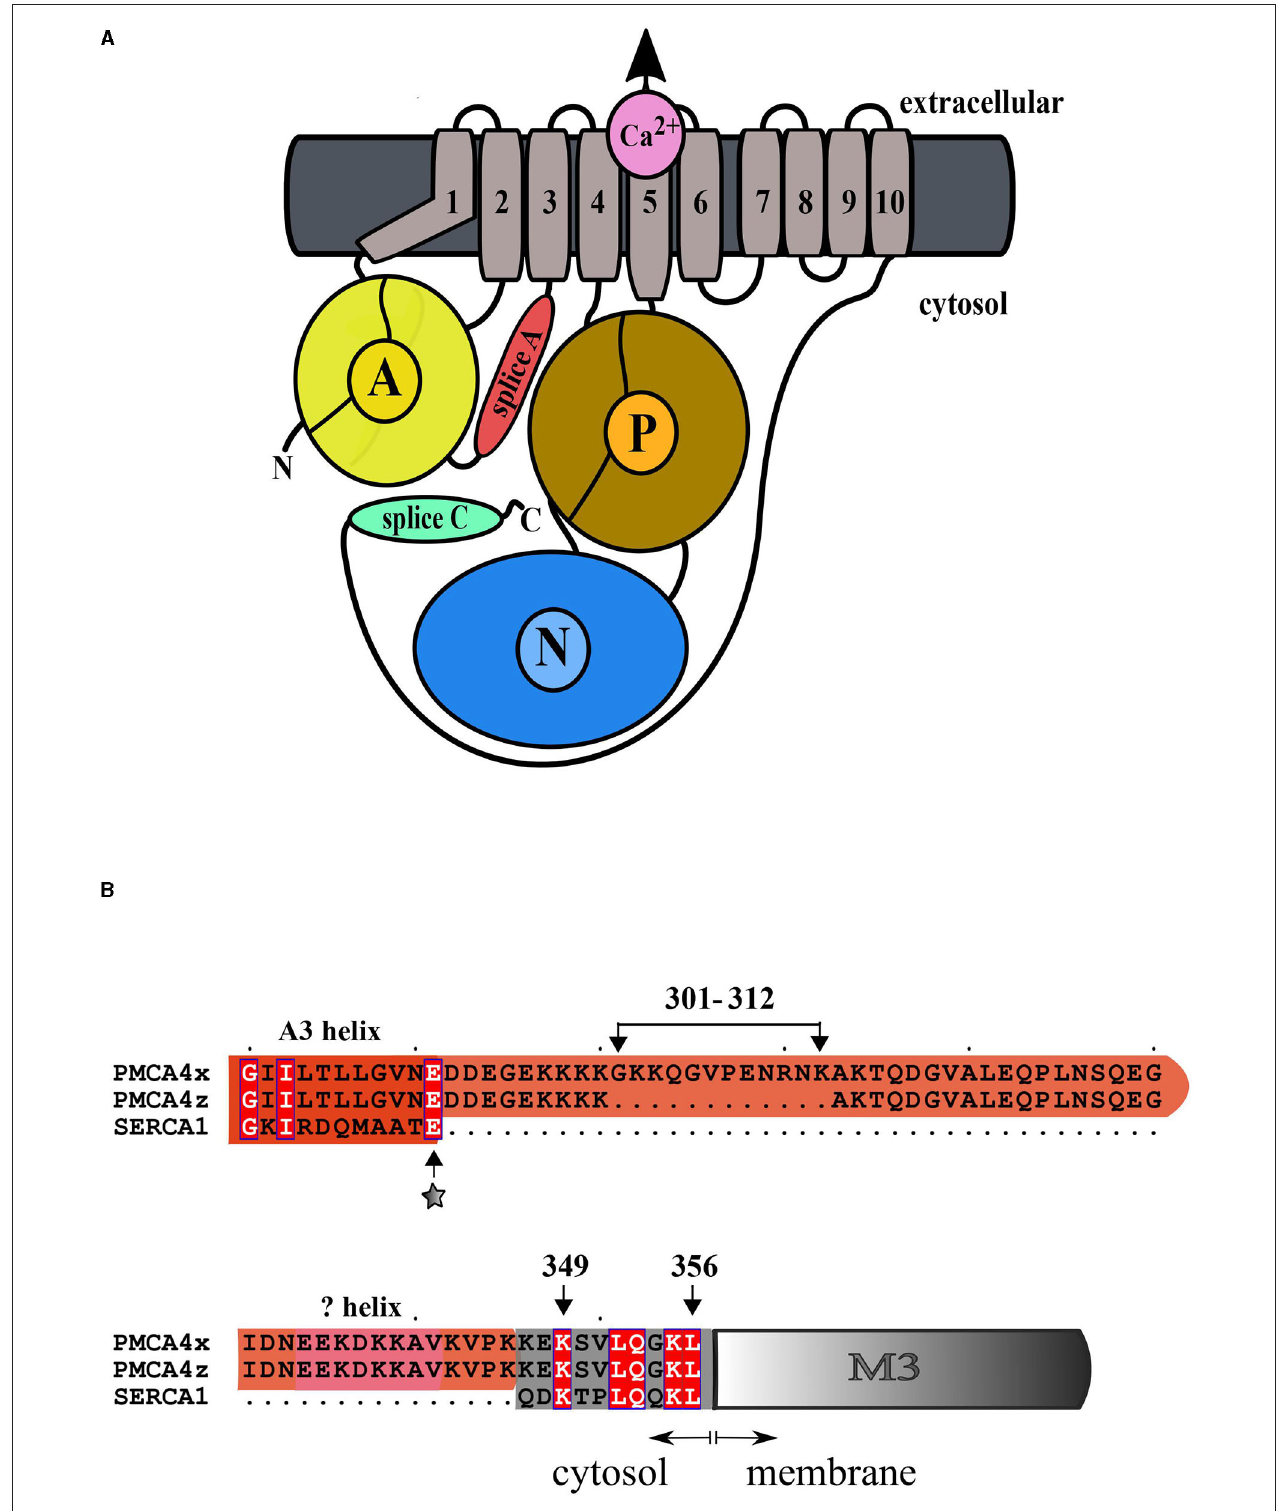
FIGURE 1 | (A) General architecture of the plasma membrane Ca 2 + (PMCA) P-ATPase. Only the catalytic subunit is represented. Helices M1-M6 constitute the transport domain. The action domain (A) is shown in yellow, the phosphorylation domain (P) is brown and the nucleotide-binding domain (N) is light blue. The